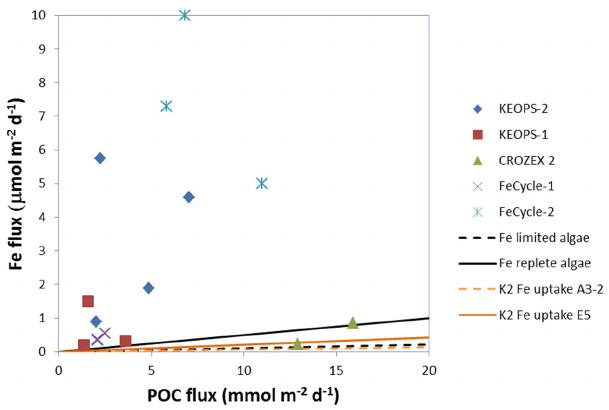
Figure 6. A comparison of export fluxes of pFe versus POC in sink- ing particles for natural iron fertilisation studies in the Southern Ocean. For details of the sampling methods, refer to Table 2 and the original articles. The lines indicate Fe / C ratios for Fe-limited (black dashed) and Fe-replete (black solid) phytoplankton (Twining et al., 2004) and the mean mixed-layer intracellular Fe / C ratios at stations A3-2 (orange dashed) and E5 (orange solid) on KEOPS- 2 (taken from Table 1). FeCycle-II had complex biogeochemical dynamics due to a storm event and subsequent deep-water mixing (during sediment trap deployment at their station A3), splitting the study into two phases (“eddy centre” and “eddy periphery”). To aid interpretation of Fe / C export data in the context of iron fertilisa- tion, only data from the pseudo-Lagrangian phase 1 (i.e. deploy- ments A1 and A2 during bloom development and export) from that study are included in this plot (Ellwood et al.,